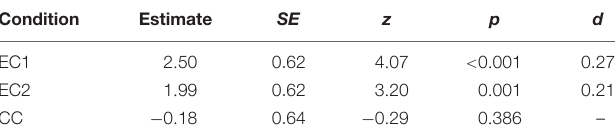
TABLE 10 | Estimated marginal means for LM3 [ F (3, 81) = 3.47, p = 0.020, R 2 = 0.11], Study 2.